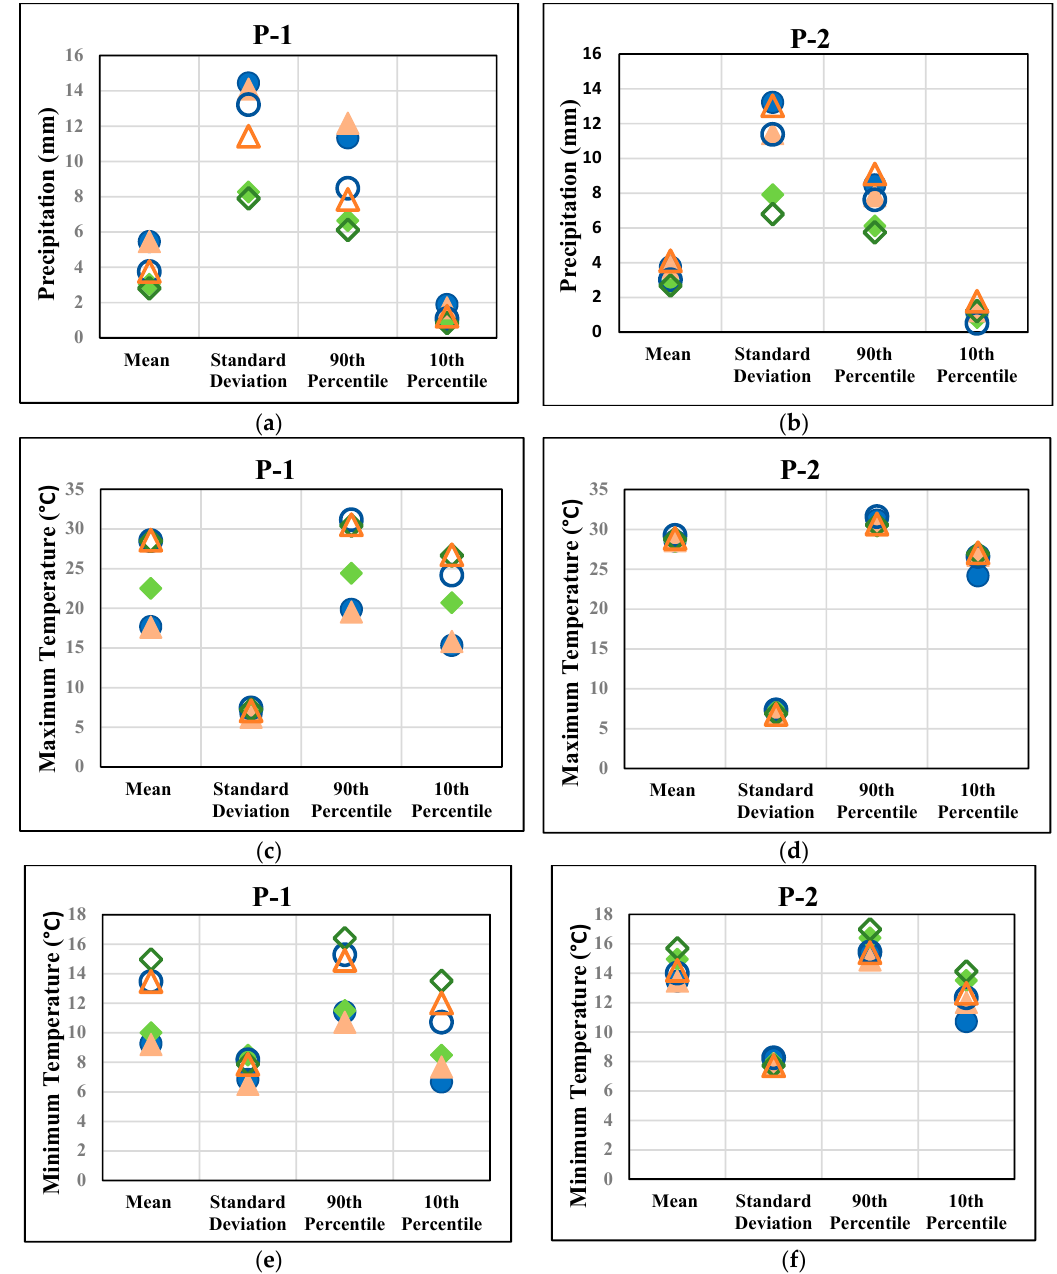
Figure 2. Line up of variation in observed (blue), non-bias corrected (green) and bias corrected (orange) statistical indicators during calibration (filled markers) and validation (hollow markers) periods for ( a ) precipitation at P-1; ( b ) precipitation at P-2; ( c ) maximum temperature at P-1; ( d ) maximum temperature at P-2; ( e ) minimum temperature at P-1; ( f ) minimum temperature at P-2.